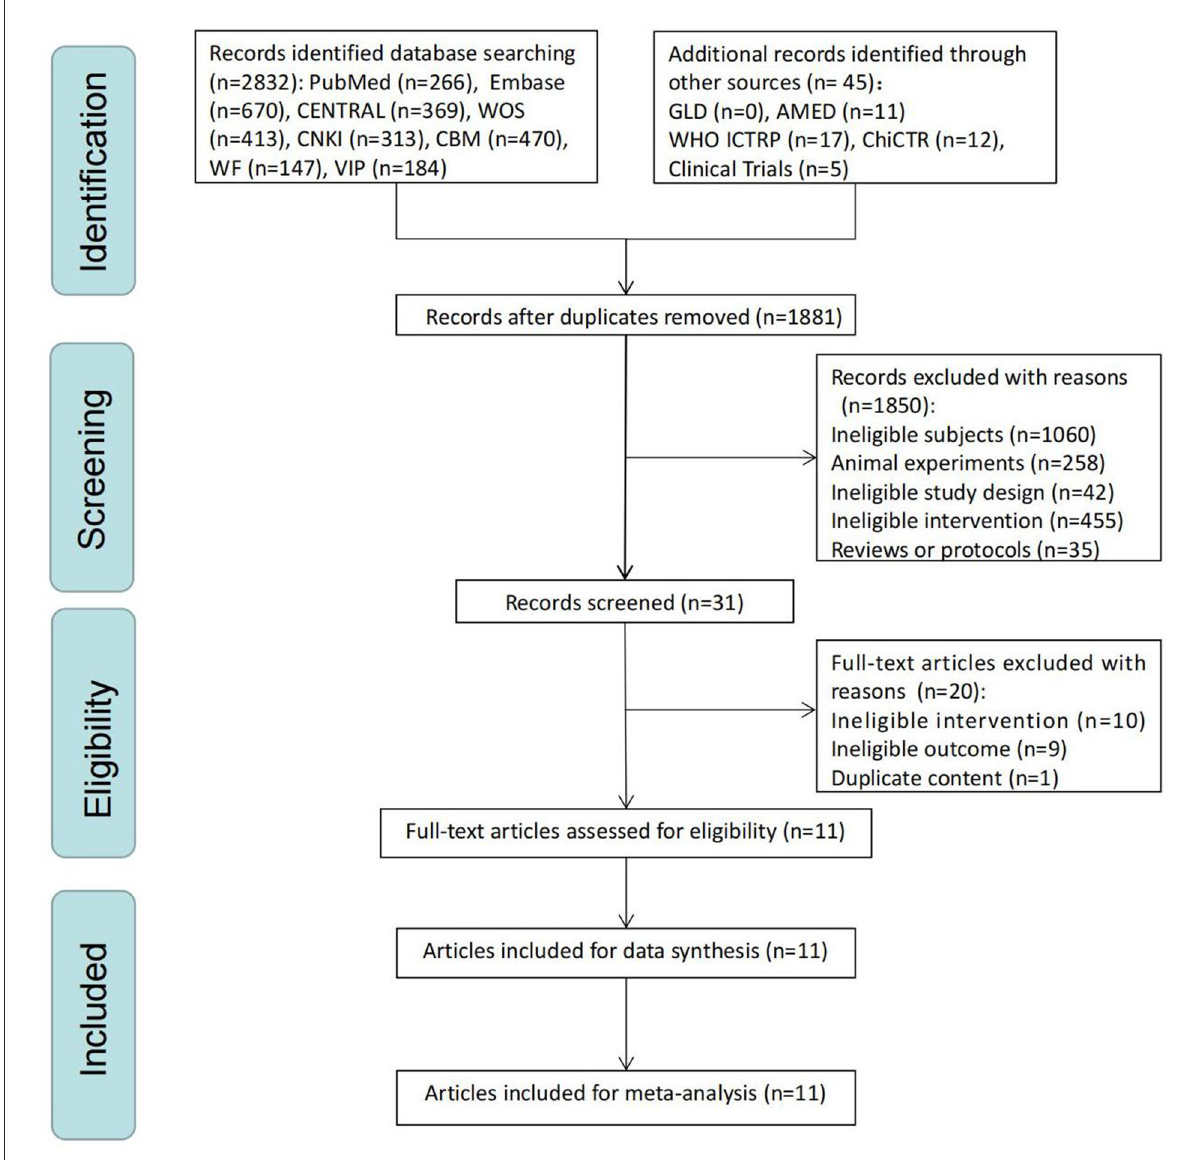
FIGURE1 The Preferred Reporting Items for Systematic Review and Meta-Analysis (PRISMA) flow chart of a selection